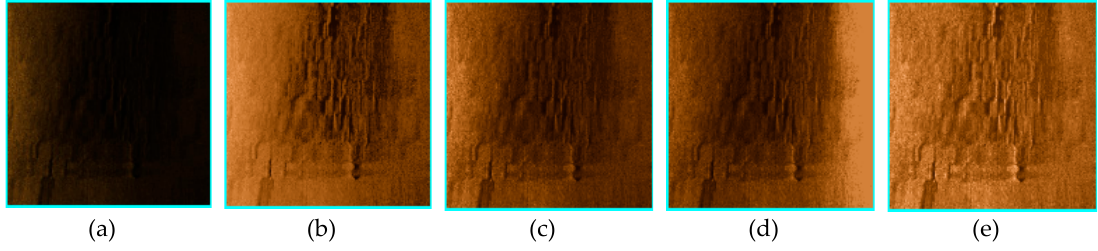
Figure 17. Local enlargement of Figure 15: (a) the original side-scan sonar image, and the images produced using the (b) histogram, (c) non-linear compensation, (d) function fitting, and (e) our methods.